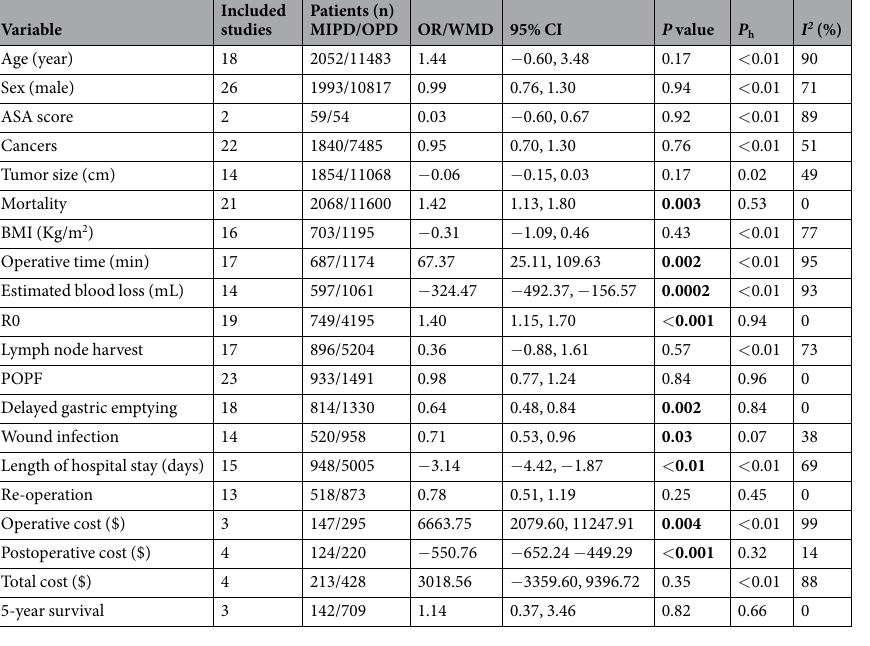
Table 2. Meta-analysis of different outcomes variables. P value: P value for the overall effect; P h : P value for heterogeneity; ASA: American Society of Anesthesiologists; BMI: body mass index (Kg/m 2 ); POPF: